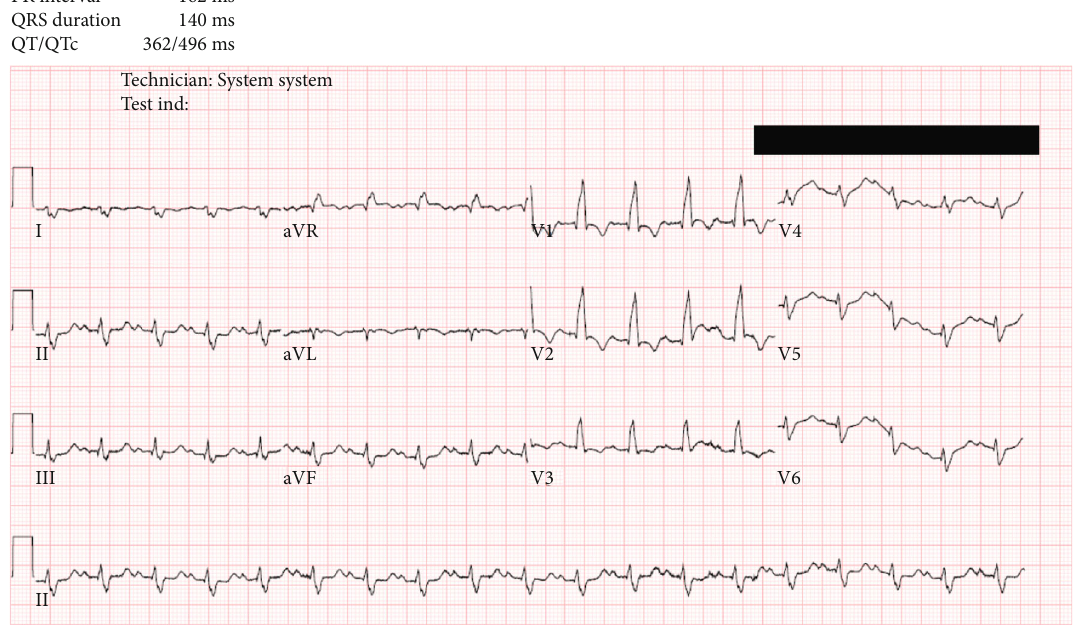
Figure 1: Initial electrocardiogram (EKG) demonstrating right bundle branch block, right axis deviation, and sinus tachycardia.